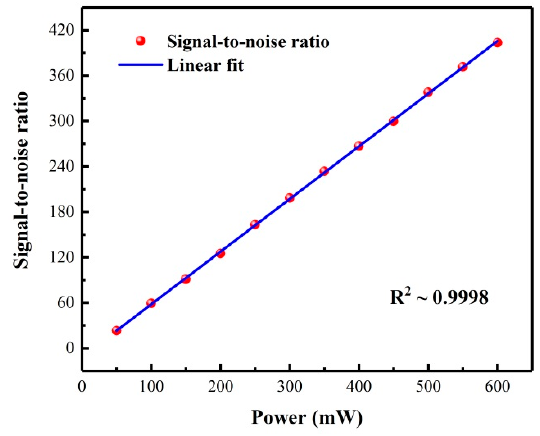
Figure 5. NO 2 PAS signal-to-noise ratio as a function of the laser average power.